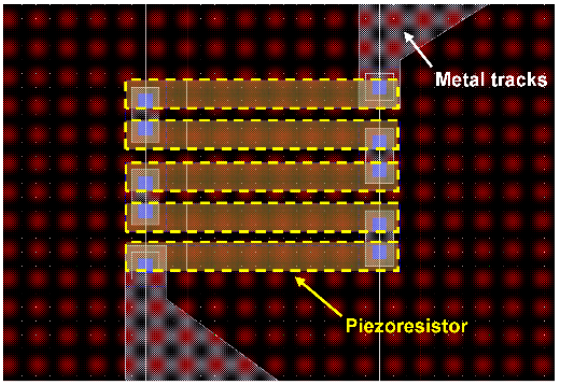
Figure 6. Cadence layout of a meander piezoresistor embedded in the pressure sensor membrane. The piezoresistor has five segments (with each segment 16 µ m long and 2 µ m wide) joined together by metal contacts.